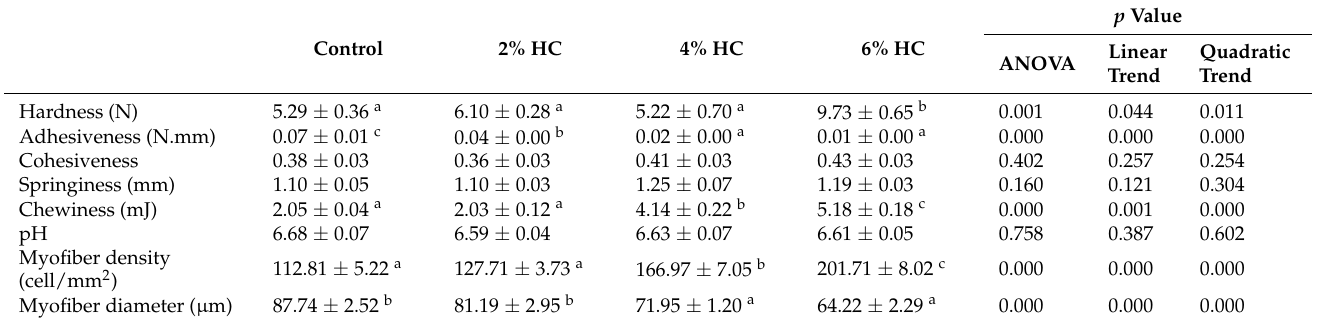
Table 10. Effects of hydrolyzed collagen replacing fish meal on muscle texture indexes, pH value, myofiber density and diameter of triploid crucian carp.